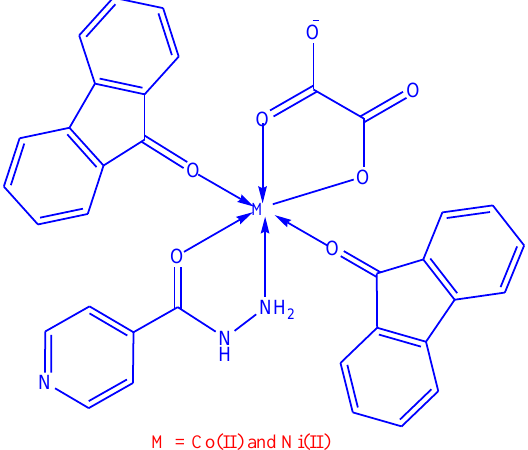
Figure 1. Schematic representation of Co(II) and Ni(II) mixed ligand complexes.